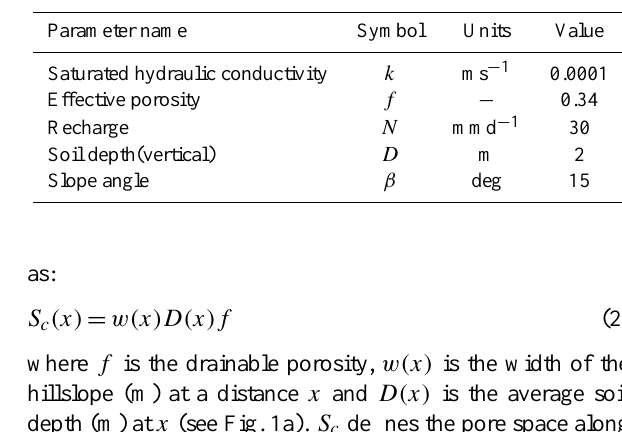
Table 2. Hydrological parameters (based on Talebi et al.,